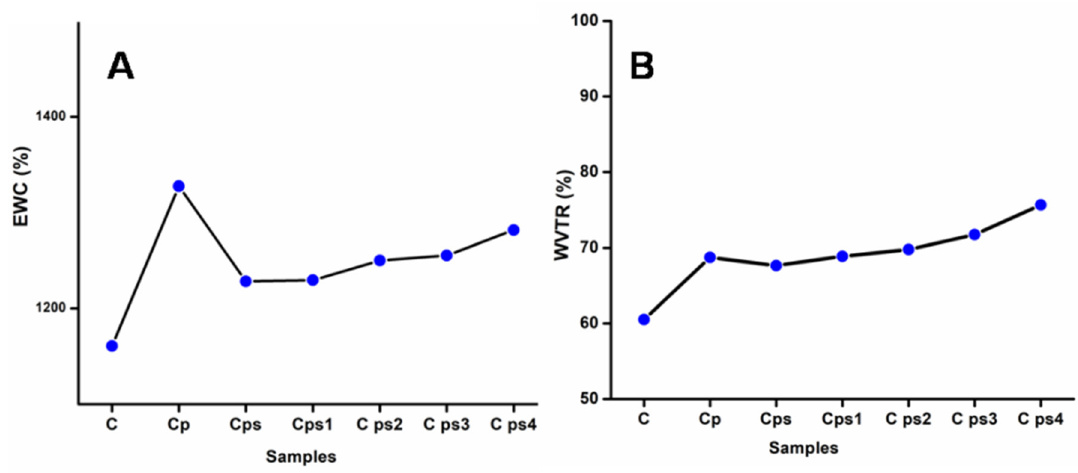
Figure 6. ( A ) Equilibrium degree of swelling of CH scaffolds ( B ) Water vapor transmission rate of CH scaffolds.